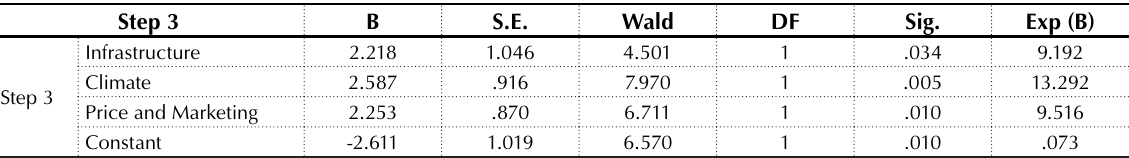
Table 4. Restricted model estimation